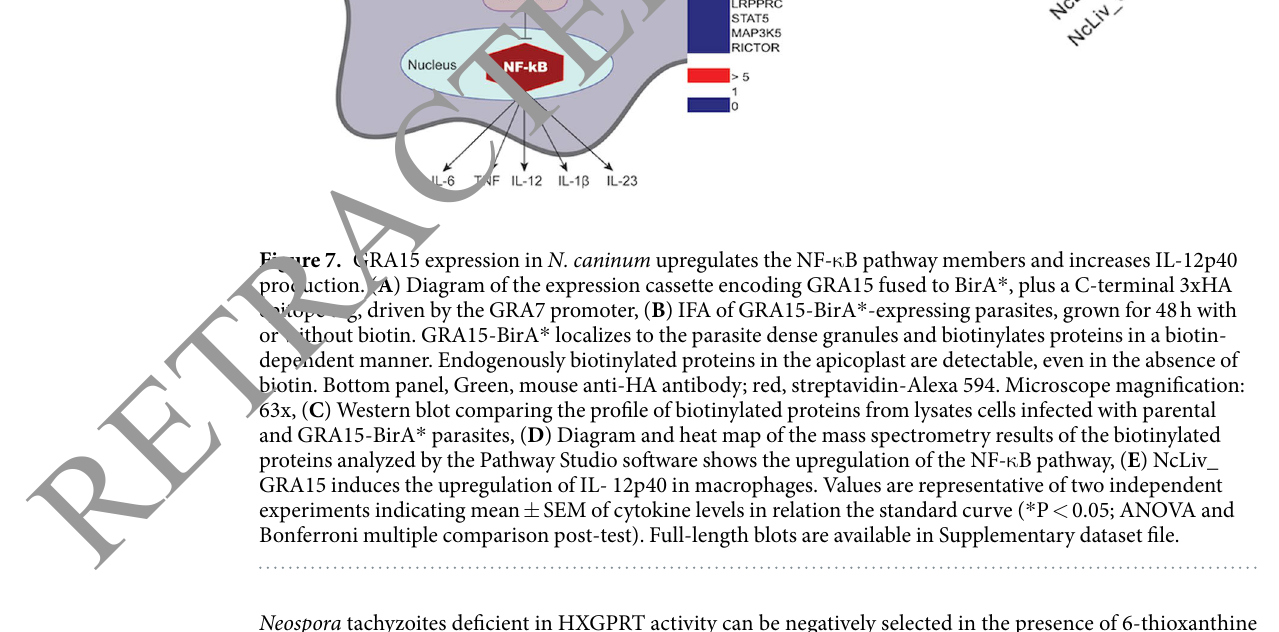
Neospora tachyzoites deficient in HXGPRT activity can be negatively selected in the presence of 6-thioxanthine (6-TX), whereas strains expressing HXGPRT activity can be selected with mycophenolic acid and xanthine (MX) positive selection. This strain will be useful for expression of transgenes in Neospora , and will also be useful as a selectable marker for knockouts via homologous recombination or CRISPR. Previous groups have attempted to engineer N. caninum tachyzoites resistant to different drugs. Pyrimethamine- resistant N. caninum was generated through the incorporation of dihydrofolate reductase-thymidylate synthase (DHFR-TS) and used to stably express the T. gondii Type I ROP18 22 and Lac-Z 25 . The chloramphenicol acetyltransferase (CAT) resistance was also previously used for the expression of the Lac-Z in N. caninum 26 . We proposed, therefore, to develop a modified NcLiv strain of N. caninum deficient in HXGPRT , which facilitates the consequent genome editing and does not alter growth and the cytokine profile, nor needs